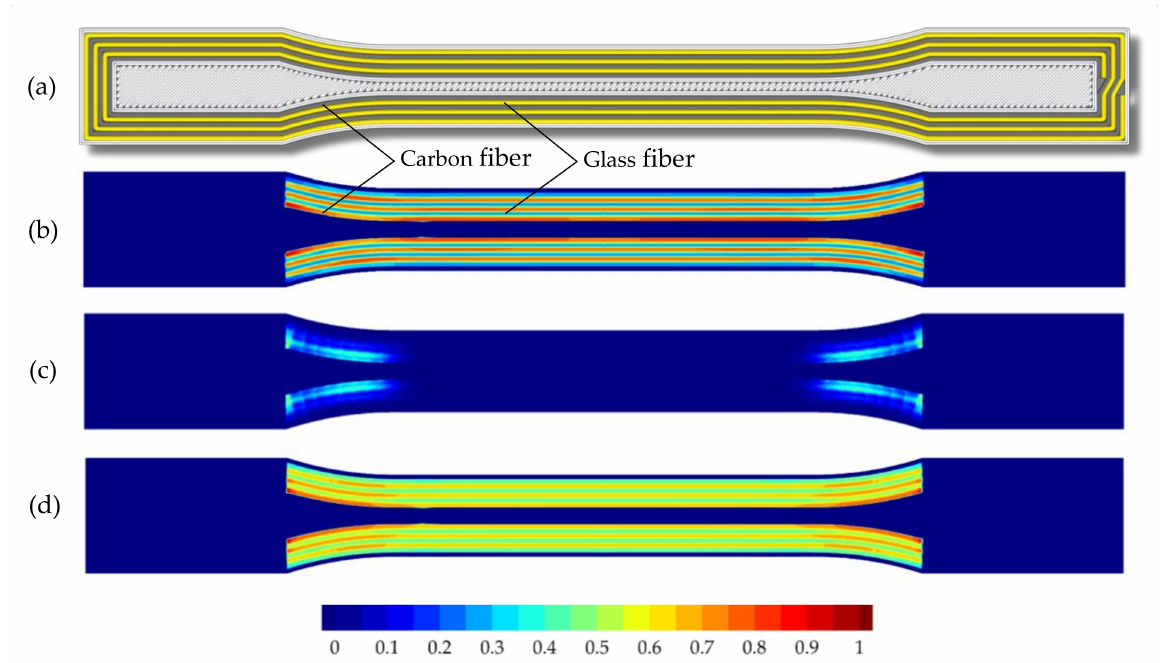
, ( c ) Hashin damage criterion– f